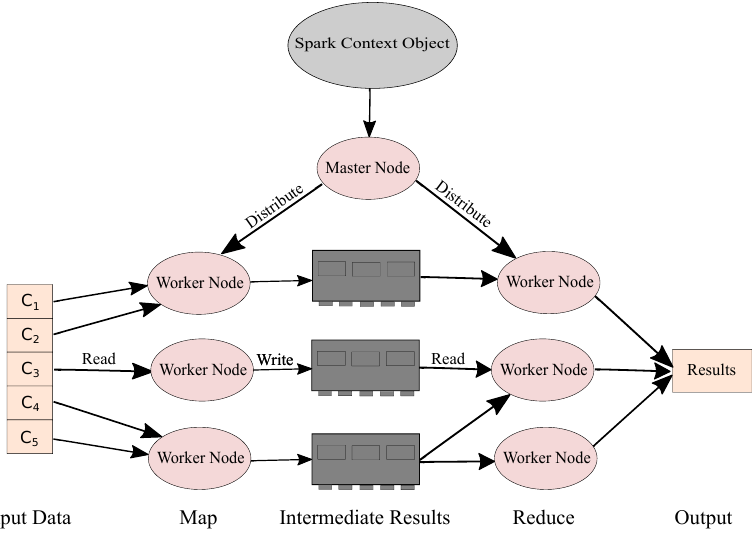
Figure 2. Working principle of the Spark framework. The input data are distributed on multiple machines (workers) and operated in parallel. The reduce operation retrieve the intermediate results and integrate it for the final results